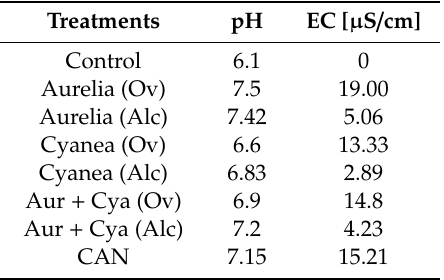
Table 3. pH and electrical conductivity (EC) values of the